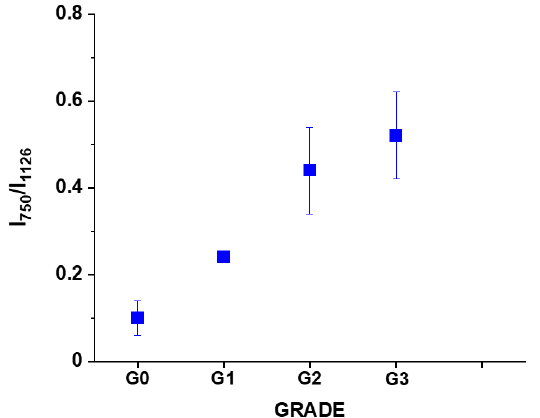
Figure 8. The Raman intensity ratio of the peaks at 750 cm − 1 and 1126 cm − 1 I 750 /I 1126 in human breast tissue as a function of breast cancer grade malignancy G0-G3 at excitation 532 nm. The results are presented as the mean ± SD. Raman bands intensity were taken from normalized by vector norm spectra.